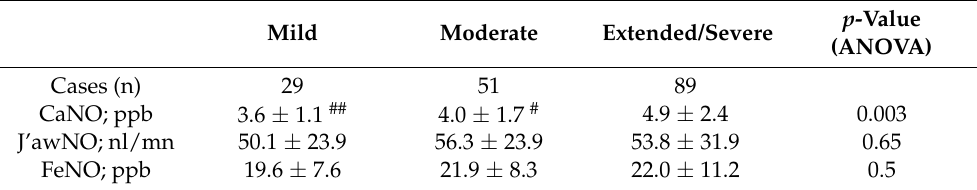
Table 3. Relation between the extent of acute lung injury on thoracic HRCT and exhaled nitric oxide in patients with recovered SARS-CoV-2 pneumonia.